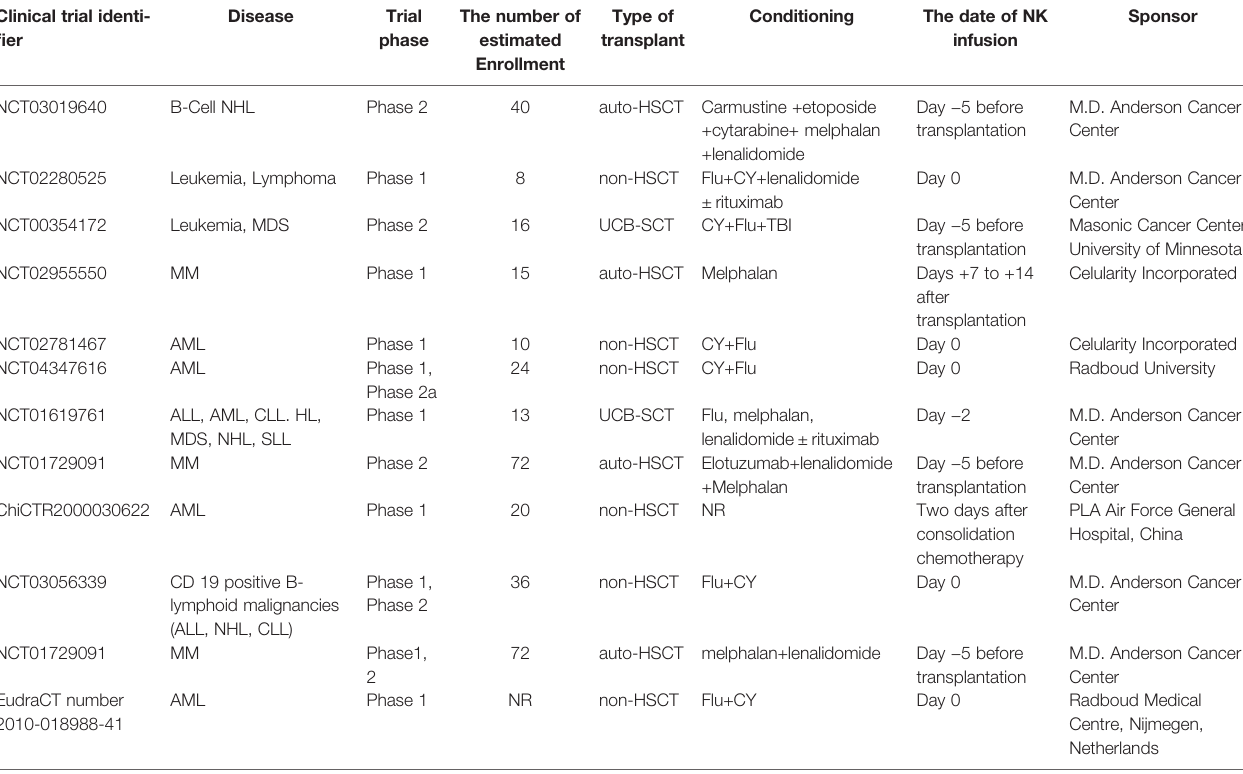
TABLE 1 | Umbilical cord blood (UCB)-derived natural killer (NK) cells-based therapies were used currently in the clinical trials. Clinical trial identi- fi